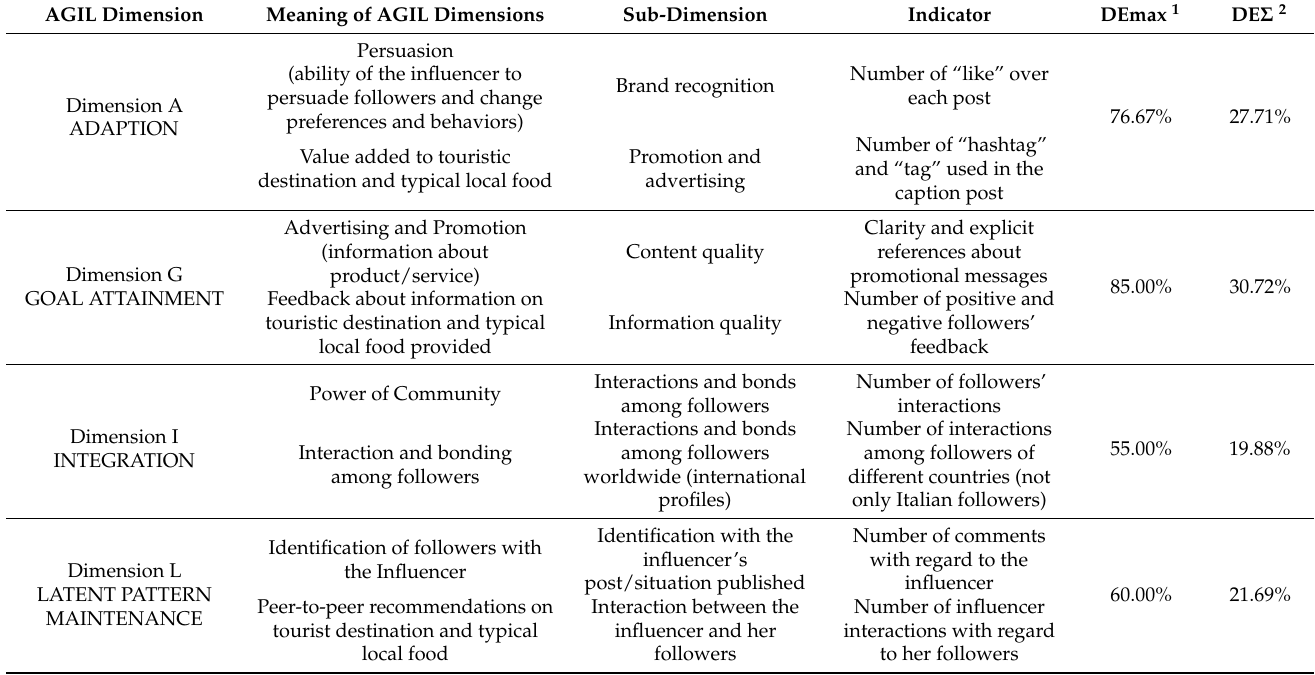
Table 1. AGIL dimensions, sub-dimensions, indicators and values of indexes of Dimension Effective- ness (DEmax and DE Σ